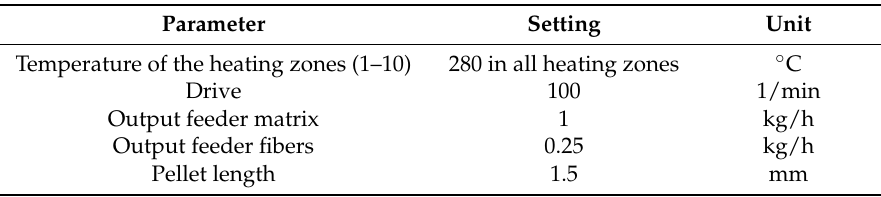
Table 5. Applied parameters of the compounding process.